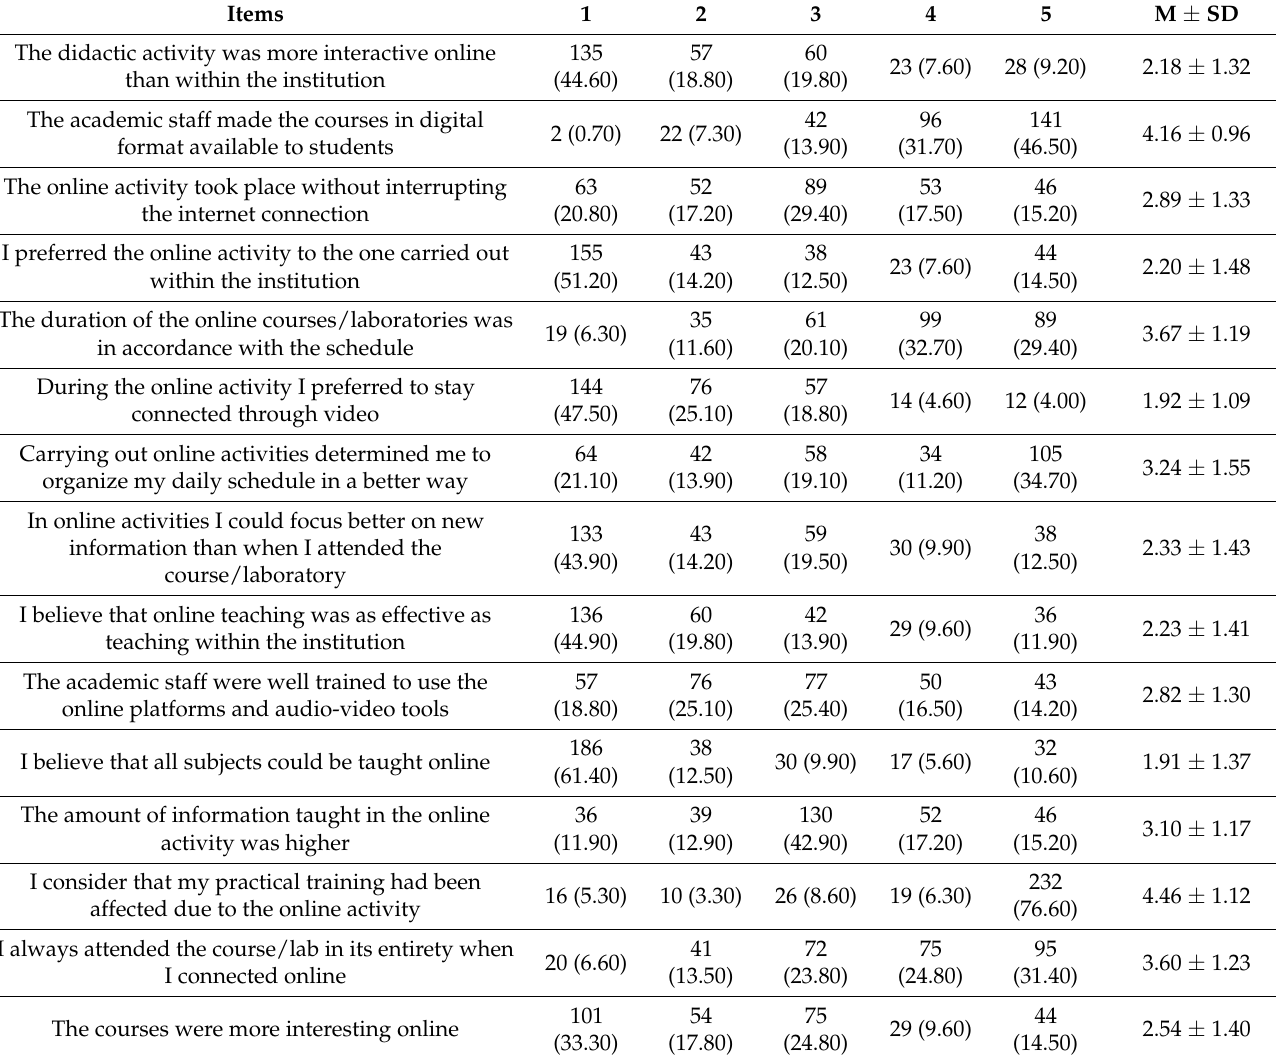
Table 4. Dentistry students’ opinions regarding online activity 1